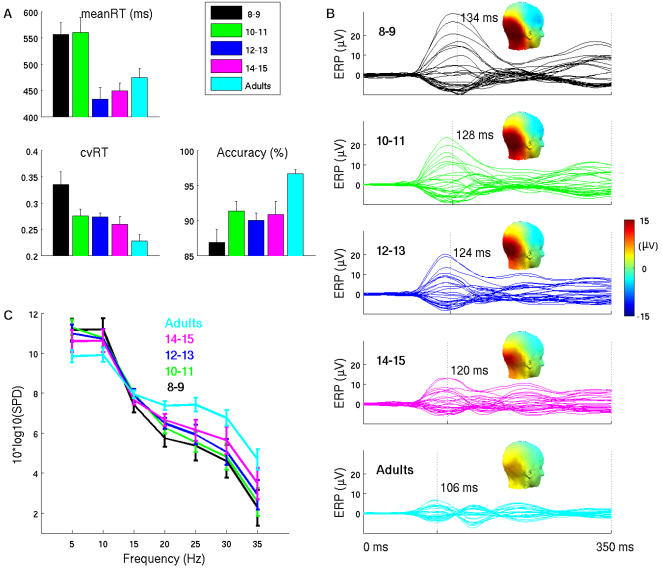
Behavior and EEG data by age.(A) Behavioral results for mean RT, coefficient of variation (cvRT) and accuracy (percent correct responses). Error bars indicate group standard errors. B) Waveforms for group average ERPs across all electrodes, together with corresponding P100 latencies (marked by vertical dashed line) and P100 scalp maps. C) Group average results for spectral power distribution (SPD) during baseline interval for electrode O2. Error bars indicate group standard errors. Similar pattern was present at all channels. With maturation, decreases were observed in lower frequencies (<10 Hz) combined with increase in higher frequencies (>10 Hz).